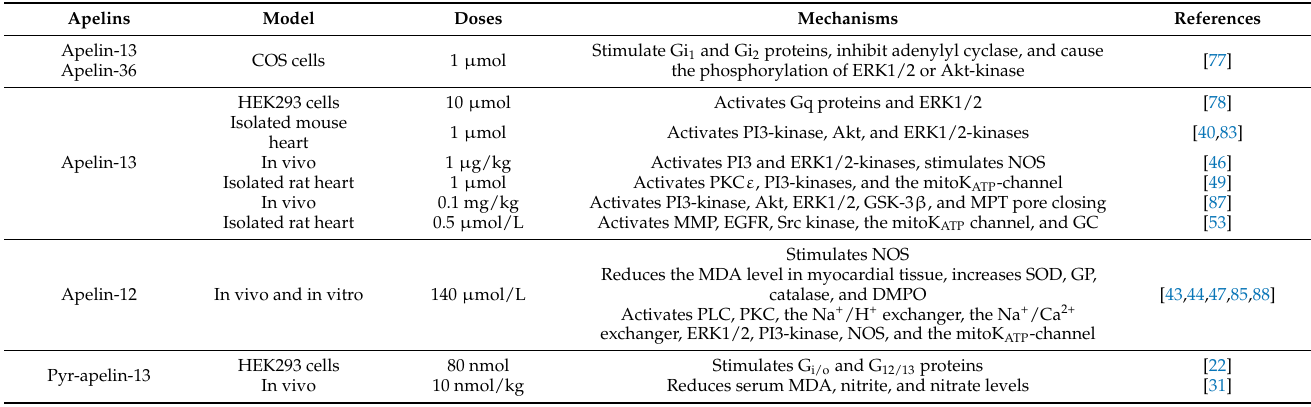
Table 3. The signaling mechanism of the cardioprotective effect of